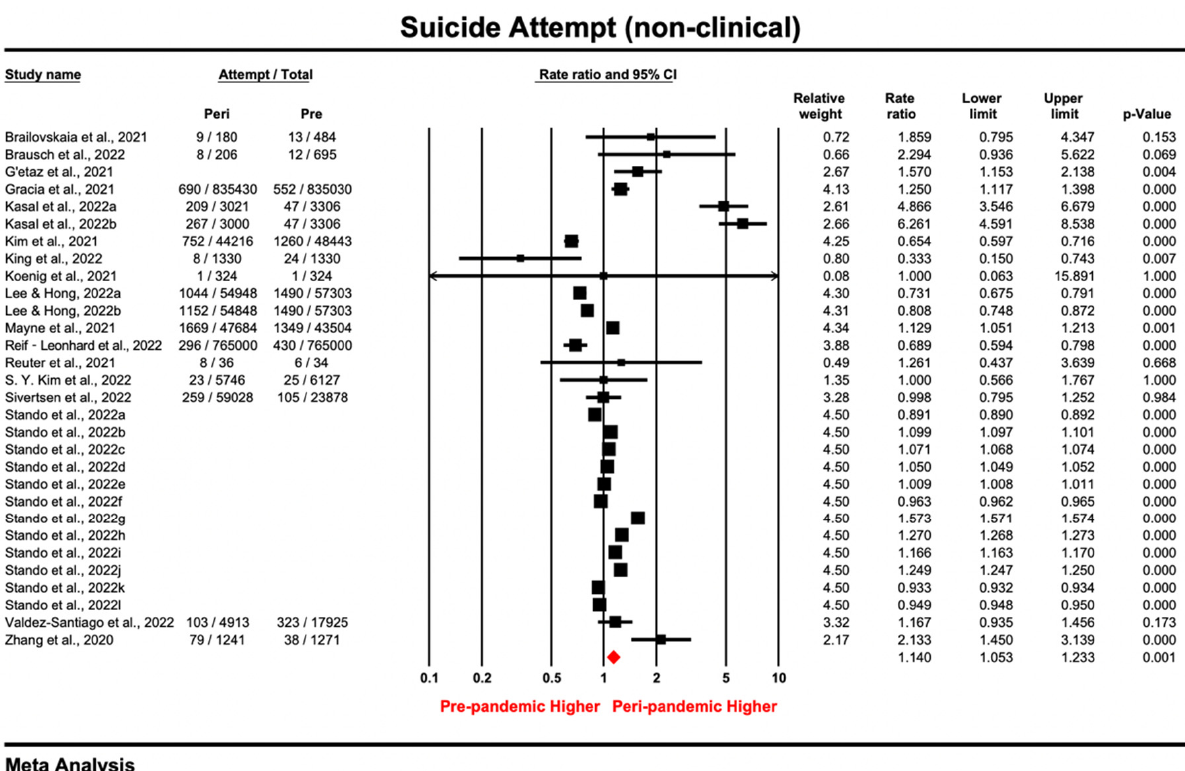
Figure 4. Forest plot for suicide attempt of studies [9,12,15,66,68,72,74,75,93,97–100,102,108,112,113] conducted in the non-clinical setting (Prismatic colored as red refers to the pooled estimate).